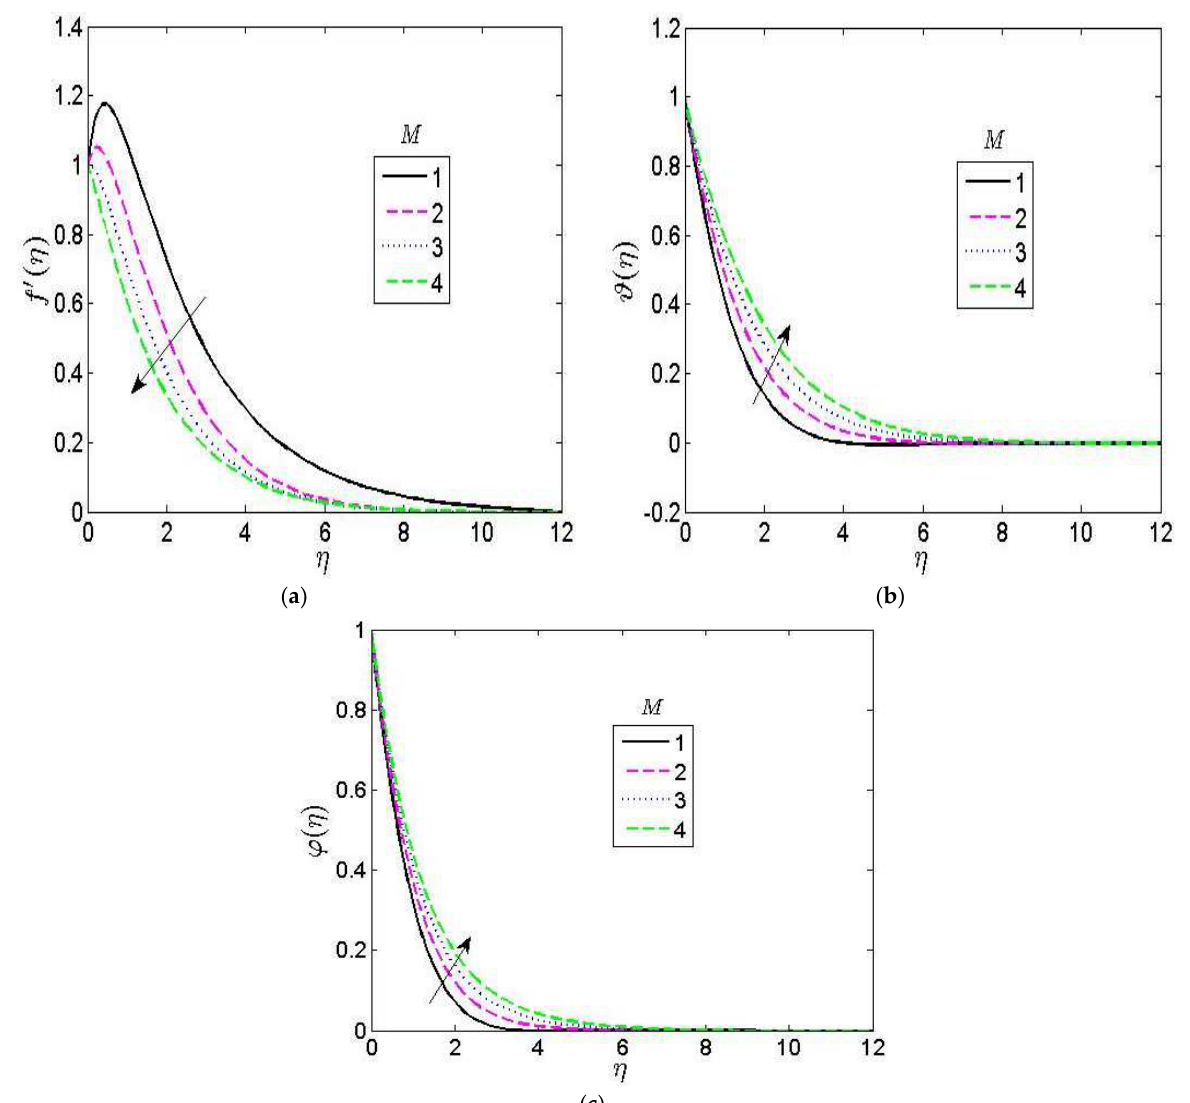
Figure 3. Effect of magnetic parameter M on ( a ) velocity, ( b ) temperature, and ( c ) concentration profiles.